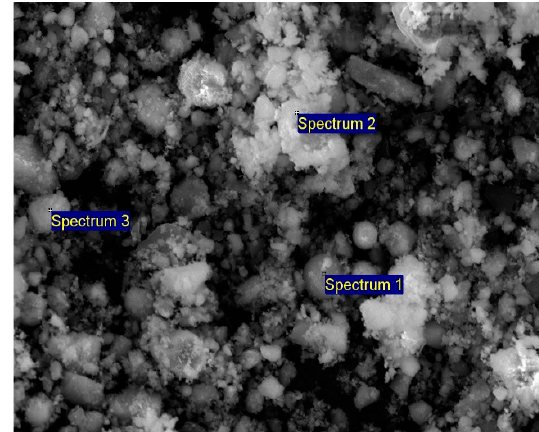
Figure 1. SEM image of the prepared composite.